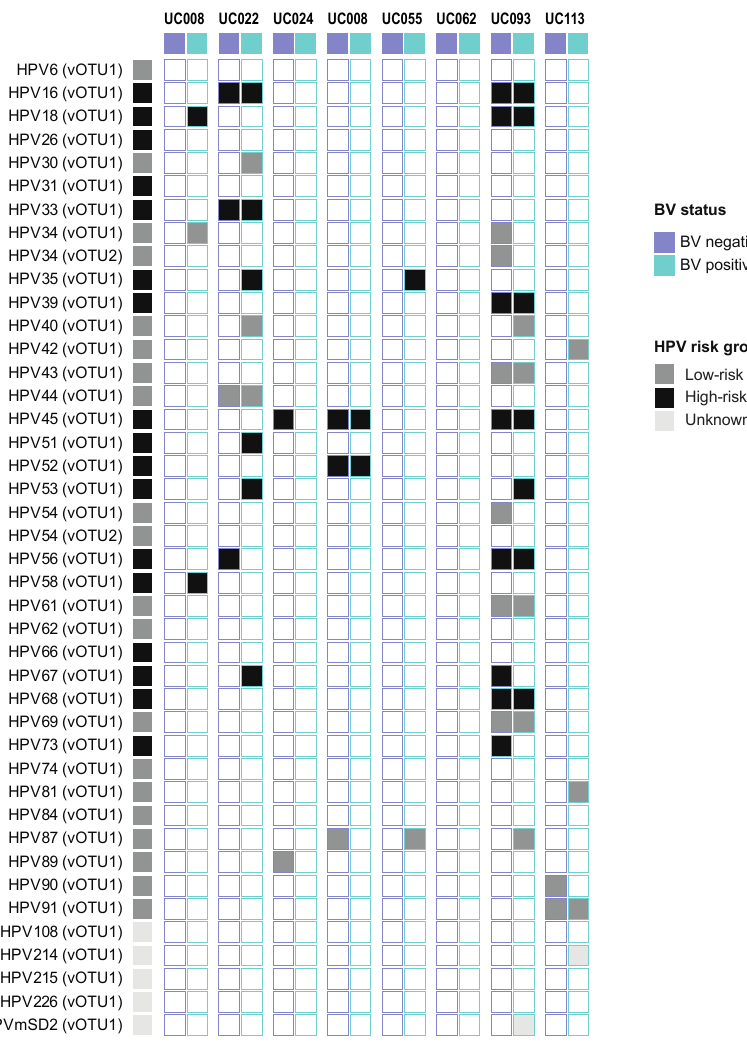
Figure 5. Evaluating presence of HPV variants in longitudinal samples from participants who experienced a change in BV status. From eight participants included in the viral metagenome sequencing project longitudinal samples were collected 4 months apart, and HPV genotype presence was evaluated in the absence (purple) and presence (blue) of BV. A variant was defined based on a 5% difference (virus operational taxonomic unit, vOTU), and the analysis was limited to vOTUs that had >75% genome coverage.